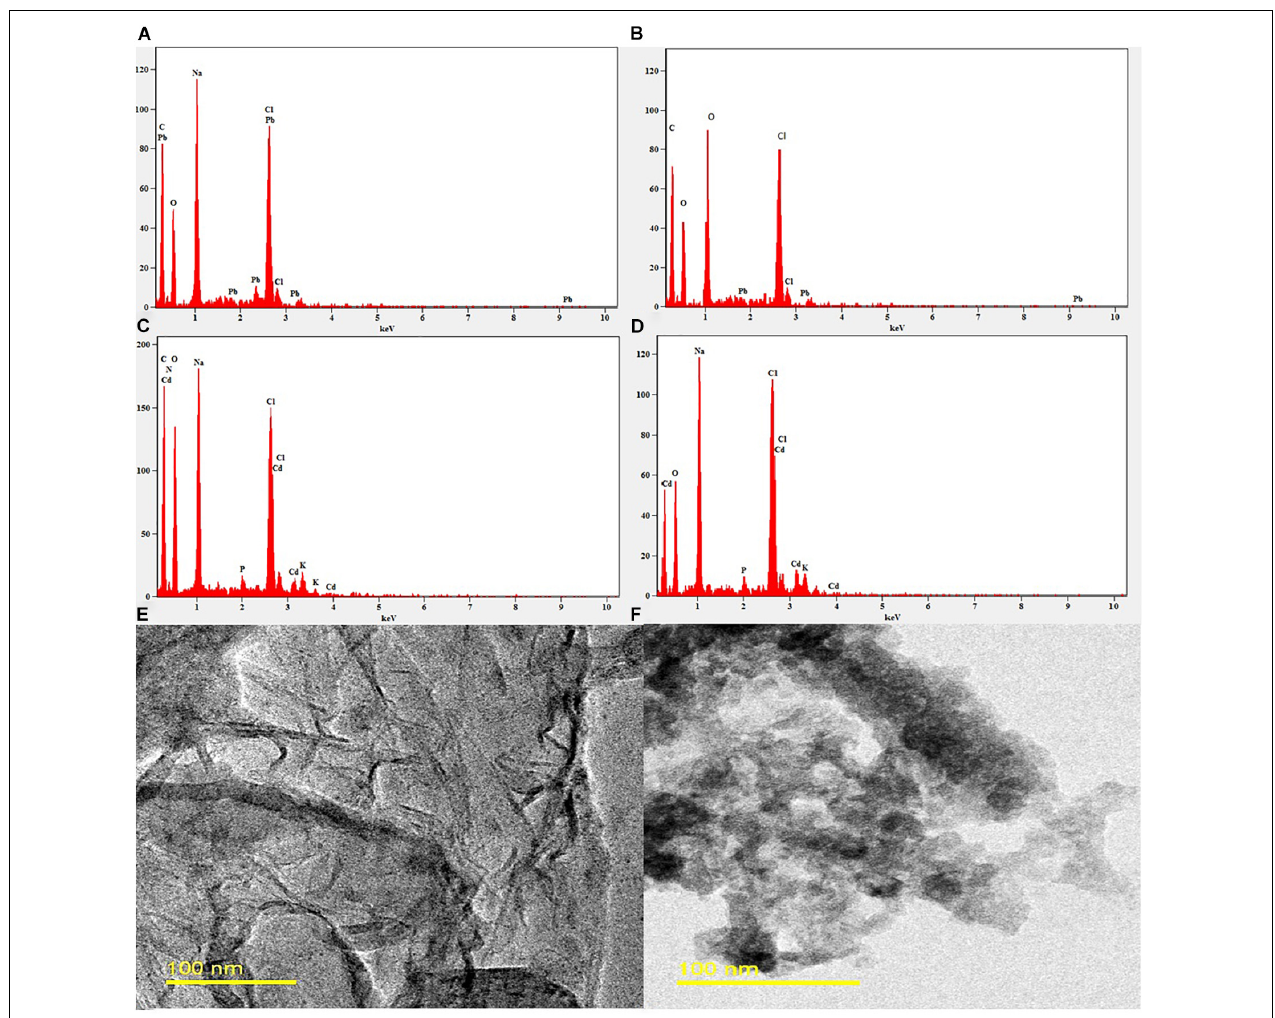
FIGURE 7 | EDX and TEM image analysis. (A) EDX of the control Pb solution. (B) EDX of the Pb solution treated with MSI 54 biosurfactant. (C) EDX of the control Cd. (D) EDX of the Cd solution treated with MSI 54 biosurfactant. (E) TEM image of the MSI 54 biosurfactant. (F) A representative image of Cd solution treated with